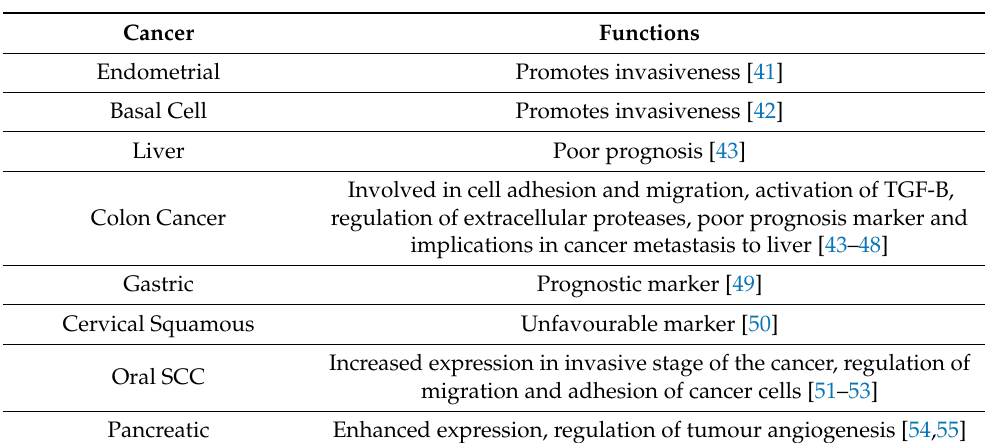
Table 1. Mechanistic implications and role of α v β 6 upon expression in different